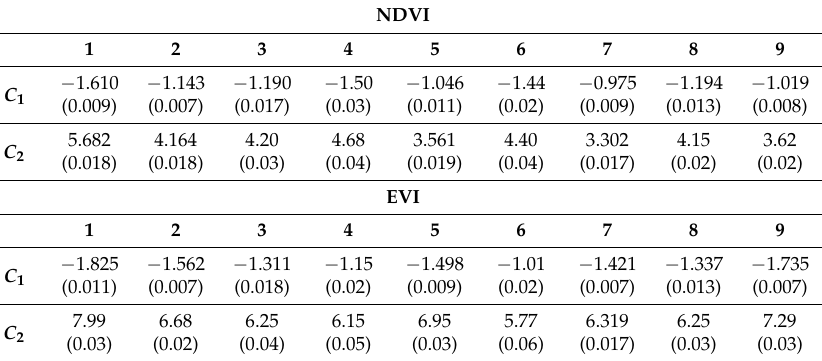
Table 4. Mean value and standard deviation (below each value, between brackets) of the regression coefficients for each land-cover type. Code: (1) irrigated lands; (2) cultivated areas; (3) cropland mosaic; (4) broad-leaved forest; (5) needle-leaved forest; (6) mixed forest; (7) shrubs; (8) herbaceous; and (9) sparse vegetation. C 1 and C 2 are expressed in kg · m − 2 · yr − 1 . Results are shown for NDVI and